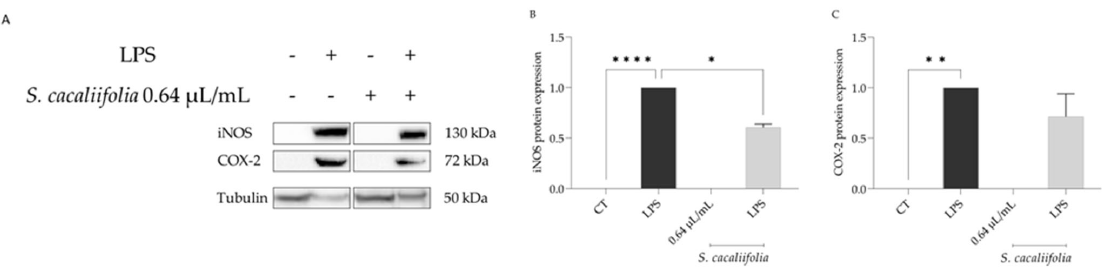
Figure 2. Effect of S. cacaliifolia essential oil on iNOS and COX ‐ 2 protein levels. ( A ) Representative blots of iNOS and COX ‐ 2 protein levels; + or − represents, respectively, the presence or absence of the condition in the table line. ( B ) Semi ‐ quantitative analysis of iNOS protein levels. ( C ) Semi ‐ quantitative analysis of COX ‐ 2 protein analysis. Protein levels were normalized to tubulin and to LPS. The results show the mean ± SEM. * p < 0.05, ** p < 0.01, **** p < 0.0001 when compared to control (CT) or LPS after one ‐ way ANOVA followed by Dunnett’s multiple comparison test.